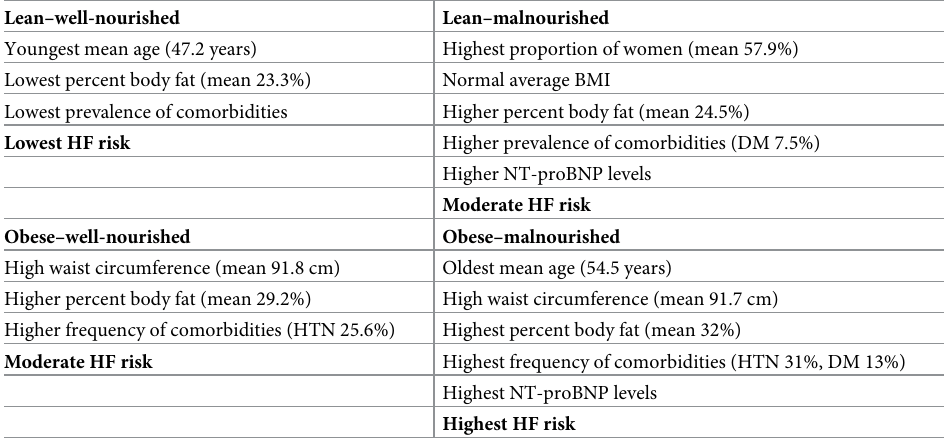
Table 4. Summary of key findings on combined subgroups of obesity and